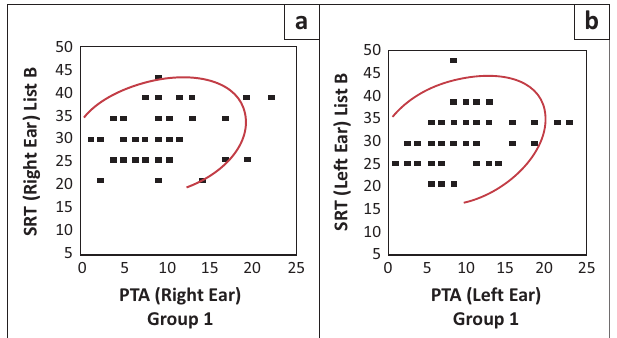
FIGURE 3: Pure-tone average/speech recognition threshold correlation for list B in group one ( N = 54R;